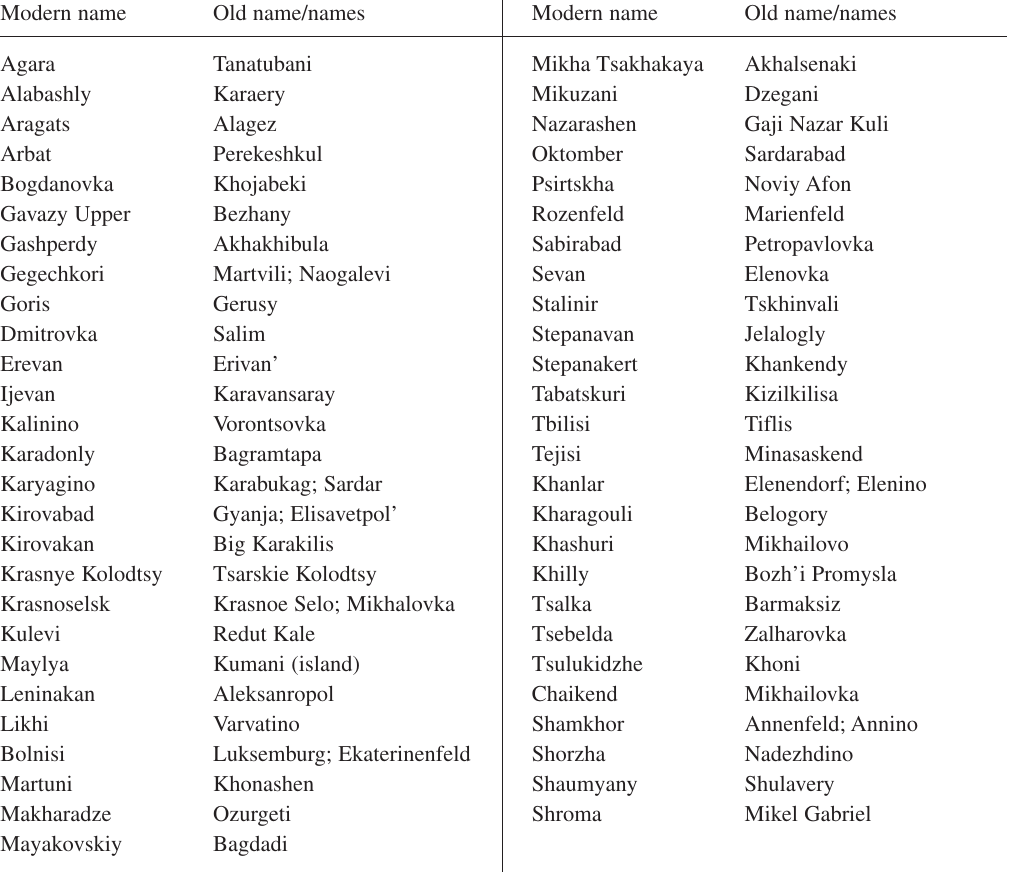
Table V. List of renamed localities in the region of Lesser Caucasus from Bius